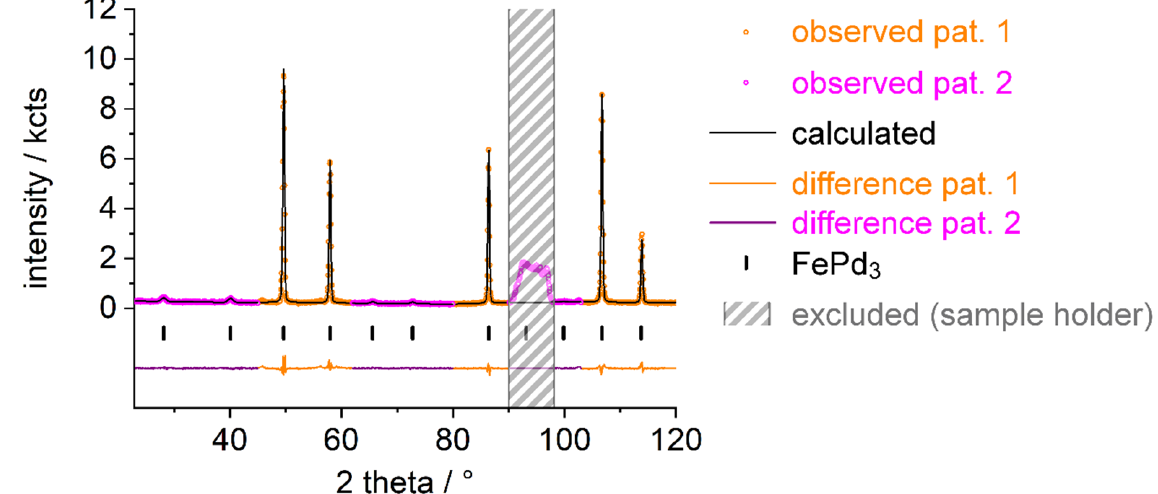
Figure A17. Rietveld refinement of the crystal structure of FePd 3 D 0.055(9) (for details, see fifth row in Tables A8 and A9) based on neutron powder diffraction data (NUMOR 131768 [21], λ =186.80(2) pm, D20 ILL, Grenoble) in a single-crystal sapphire cell at 396(3) K and 8.12(1 ) MPa deuterium pressure using FullProf [24].